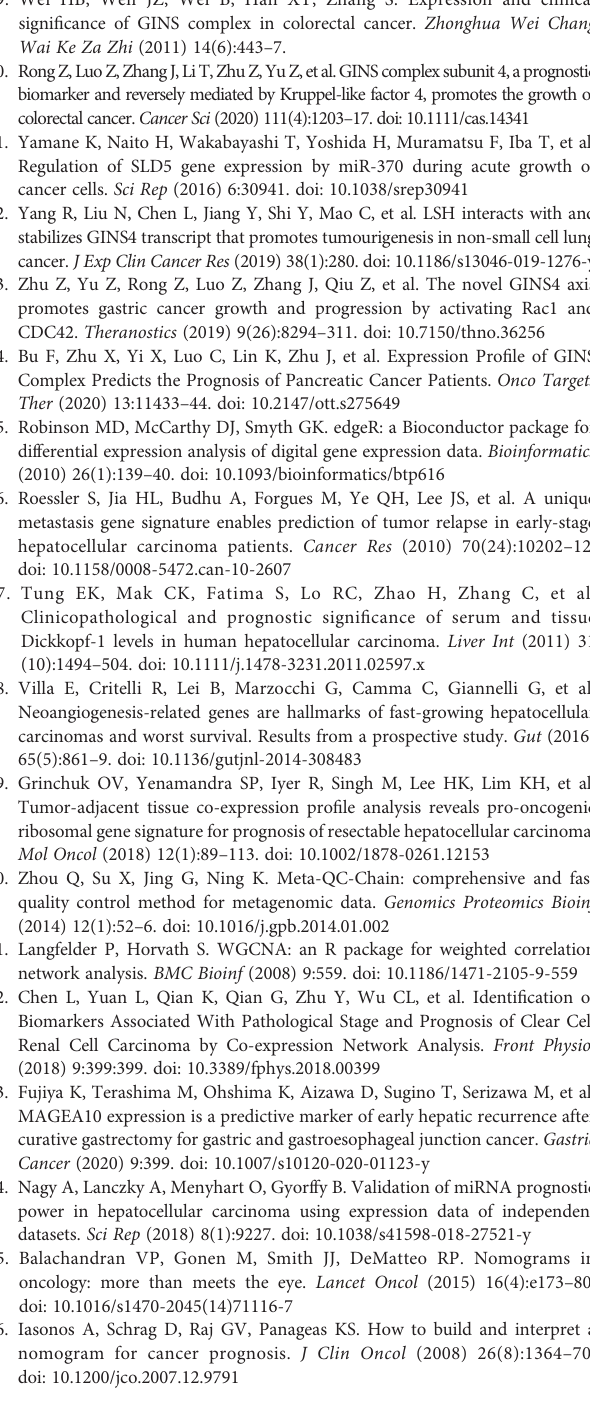
Supplementary Figure 2 | GINS4 mRNA expression in HCC patients strati fi ed by multiple clinicopathologic parameters, including (A) liver fi brosis, (B) HBV infection, (C) HCV infection, (D) vascular invasion, (E) tumor status. Supplementary Figure 3 | GINS4 exhibits a promising capability to discriminate HCC patients from healthy individuals from the TCGA database. ROC curve for (A) all HCC patients, (B) HCC patients at TNM I stage, (C) HCC patients at TNM II